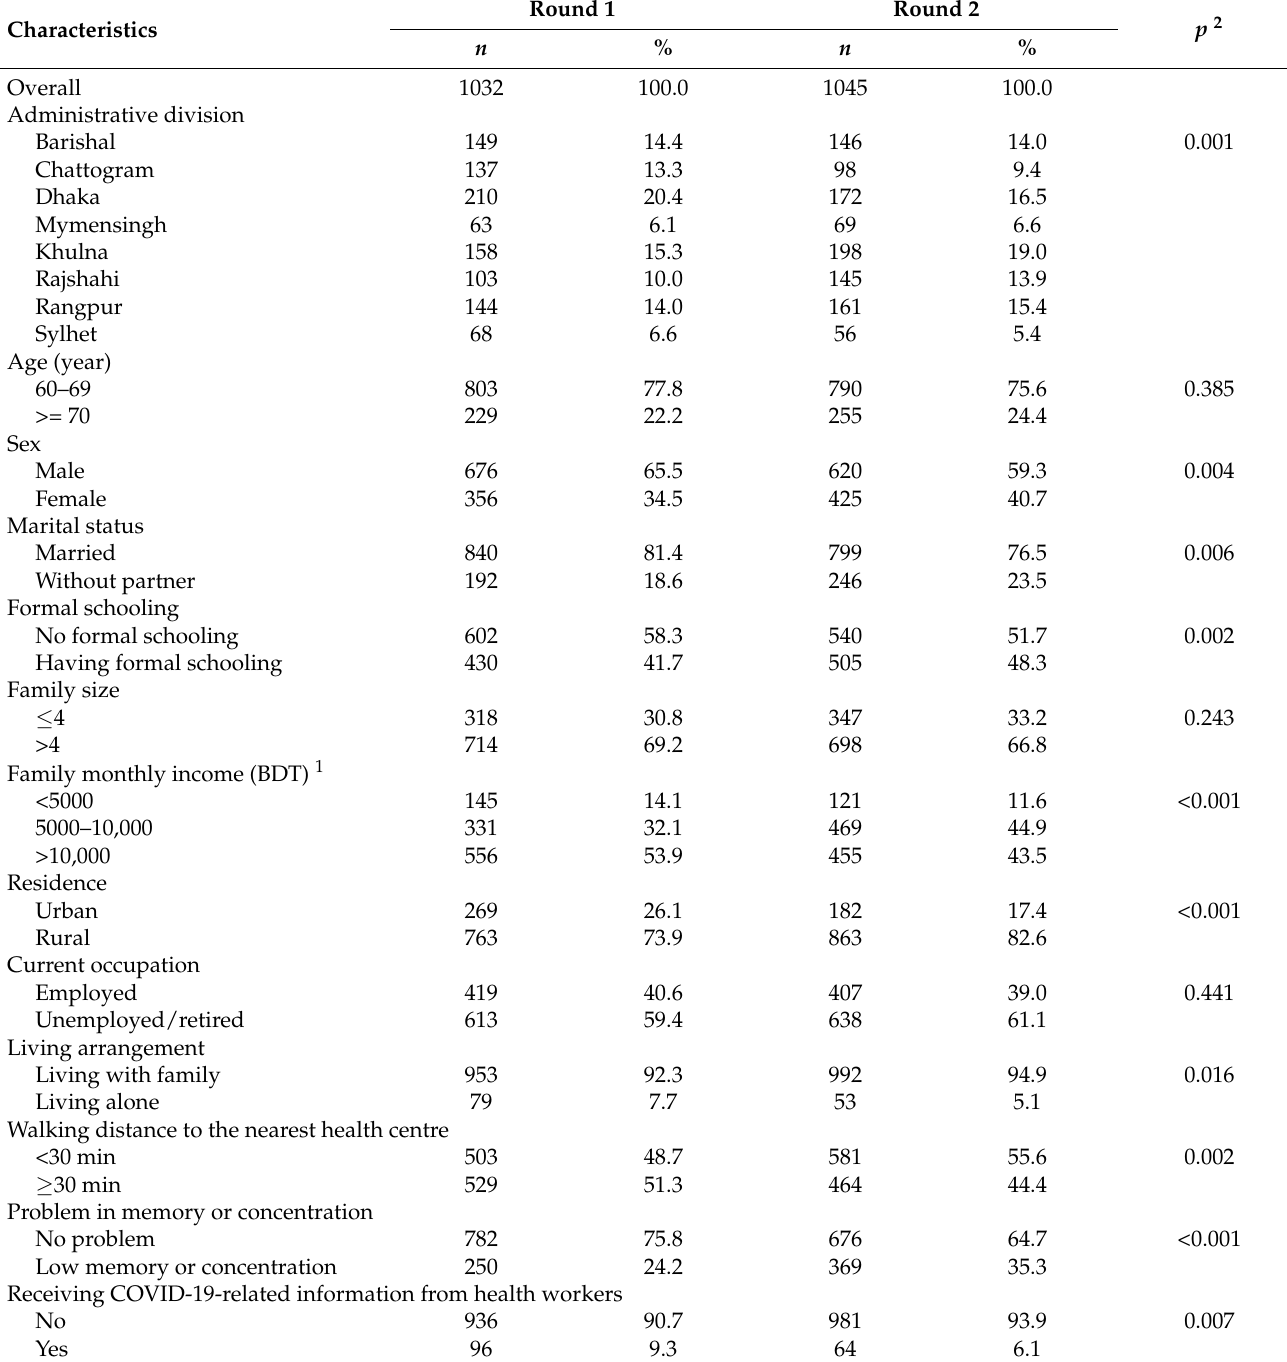
Table 1. Characteristics of the participants ( n =